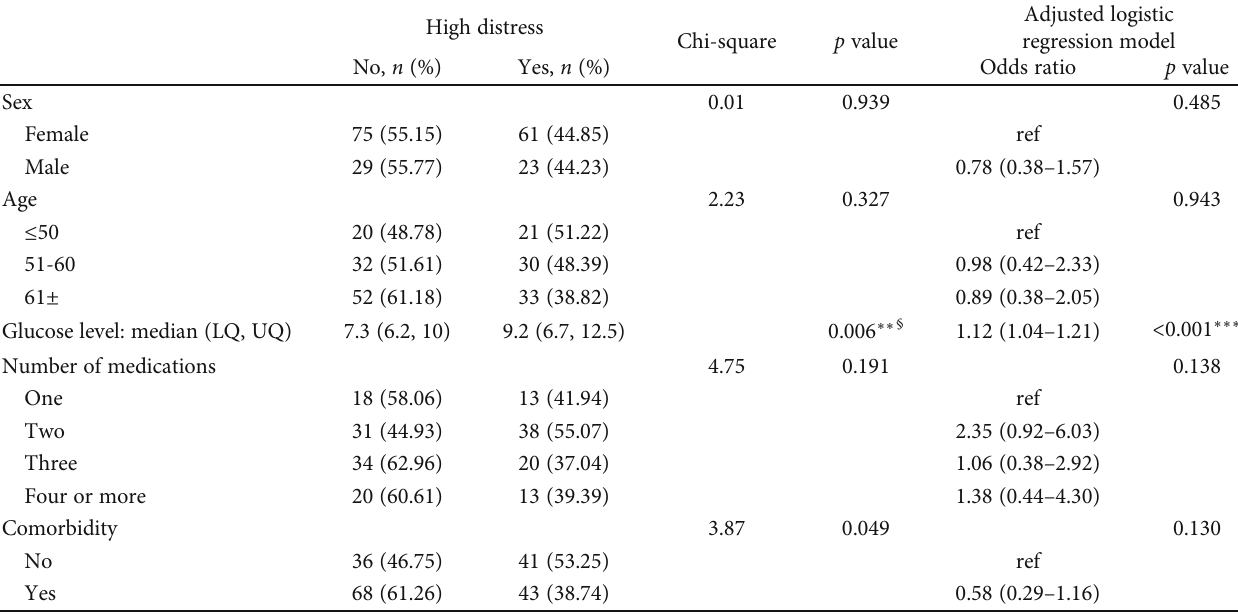
Table 2: Association between background and clinical characteristics and high distress in patients with T2DM receiving treatment at Pantang